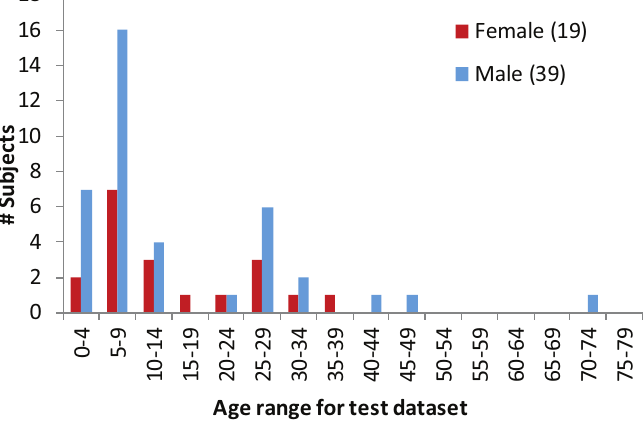
Figure 5. Distribution of subjects in test dataset—by age group and gender. The histogram demonstrates a much non-uniform distribution of age groups and gender than the training dataset.